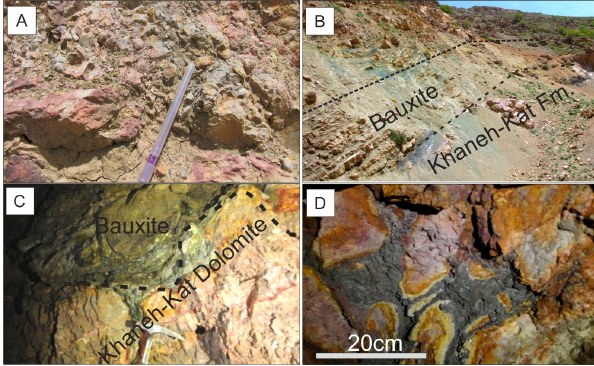
Figure 3. Field photograph of various karst features in the Upper Khaneh–Kat Formation: ( A ) Brecciated argillite; ( B ) Bauxite horizon and relationship with the Khaneh–Kat Formation (footwall dolomite); ( C ) Iron-rich bauxite-filled sinkhole in karst in the Khaneh–Kat Formation; ( D ) Karstified footwall filled with iron-rich bauxite detritus.